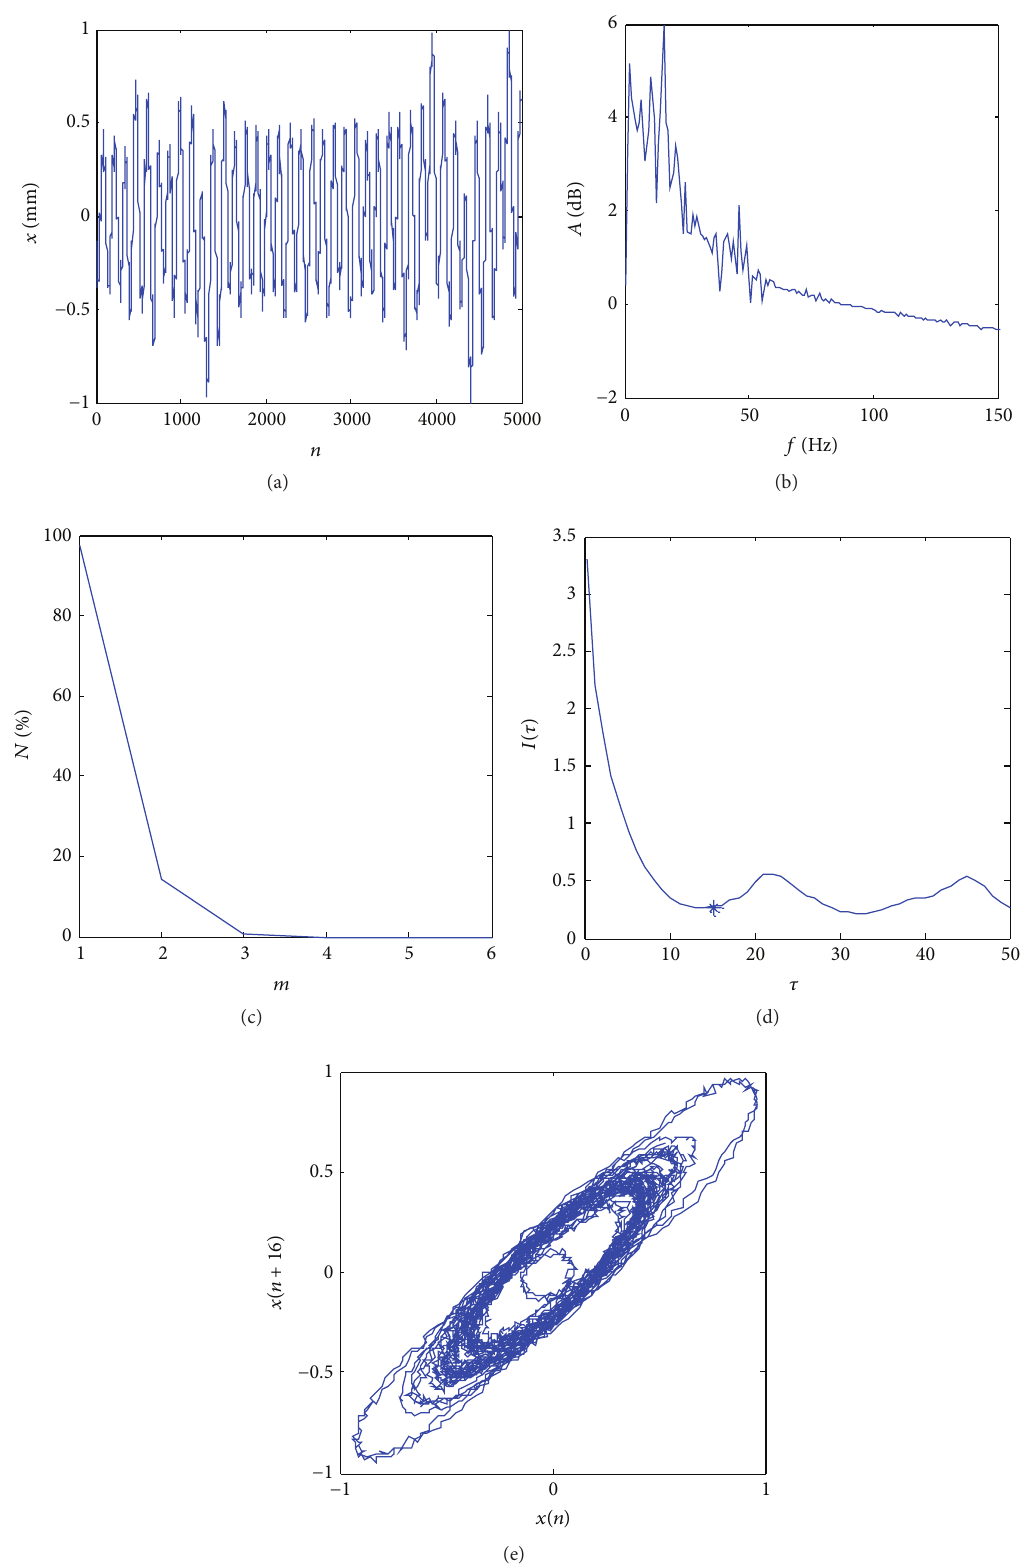
Figure 13: Vibration response when system gain is 0.98. (a) Time history of the response. (b) Spectrum of the response. (c) FNN embedding dimension. (d) FMMI reconstruction delay time. (e) Reconstructed chaotic attractor of